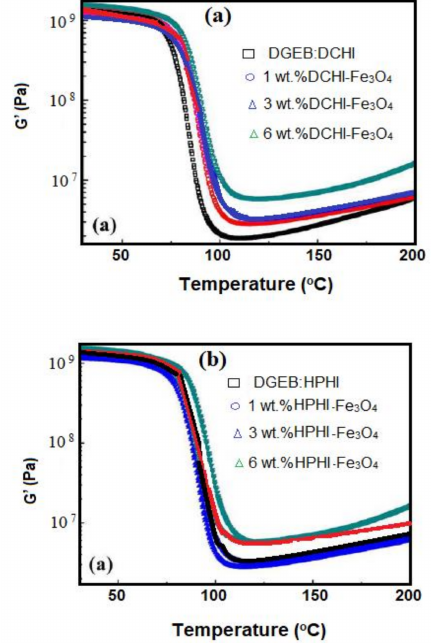
Figure 11. Storage modulus data of ( a ) DGEB / DCHI and ( b ) DGEB / HPHI and their magnetite